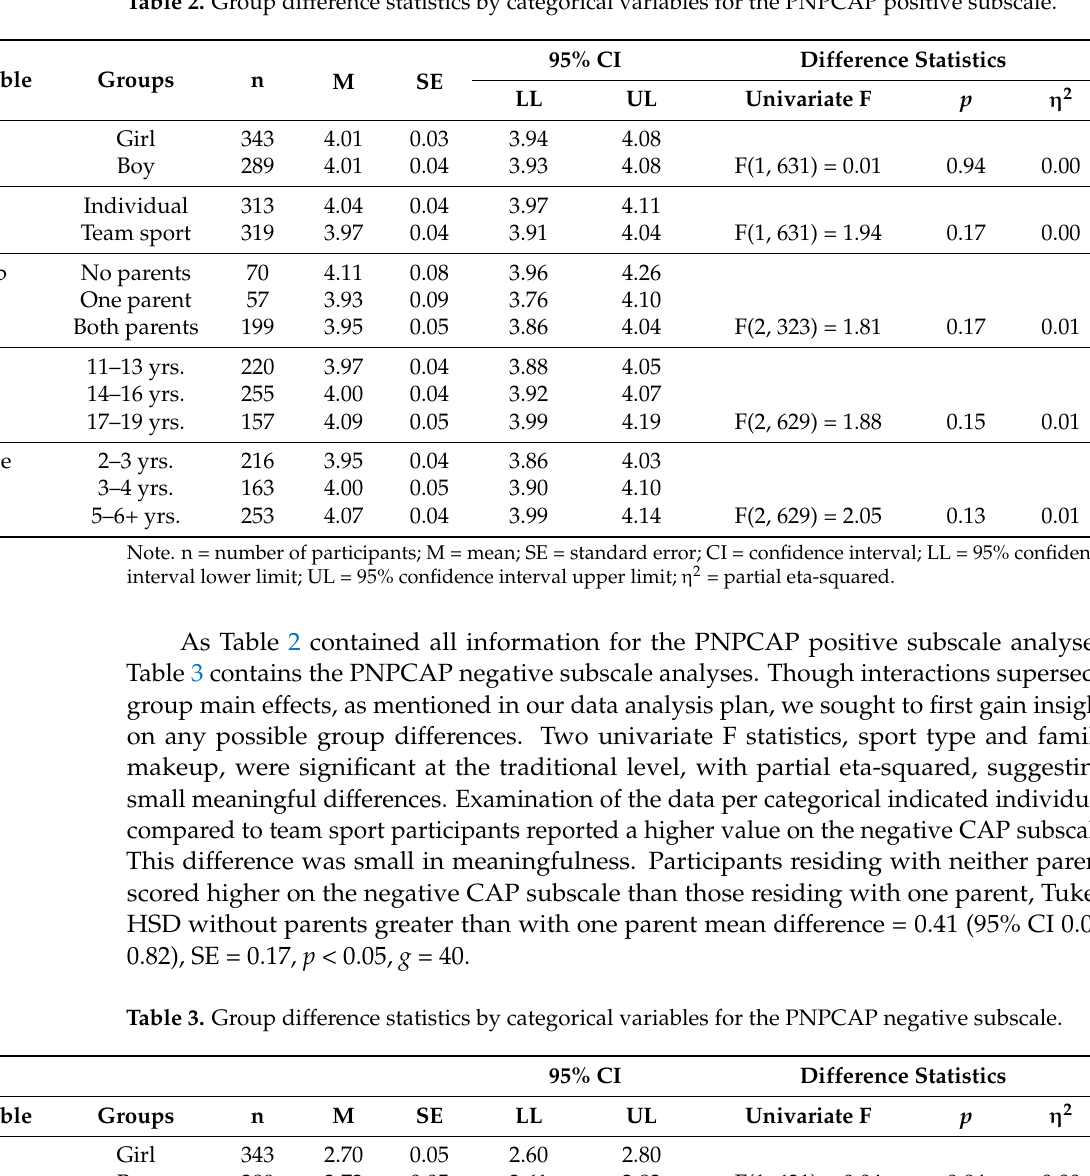
Table 2. Group difference statistics by categorical variables for the PNPCAP positive subscale.